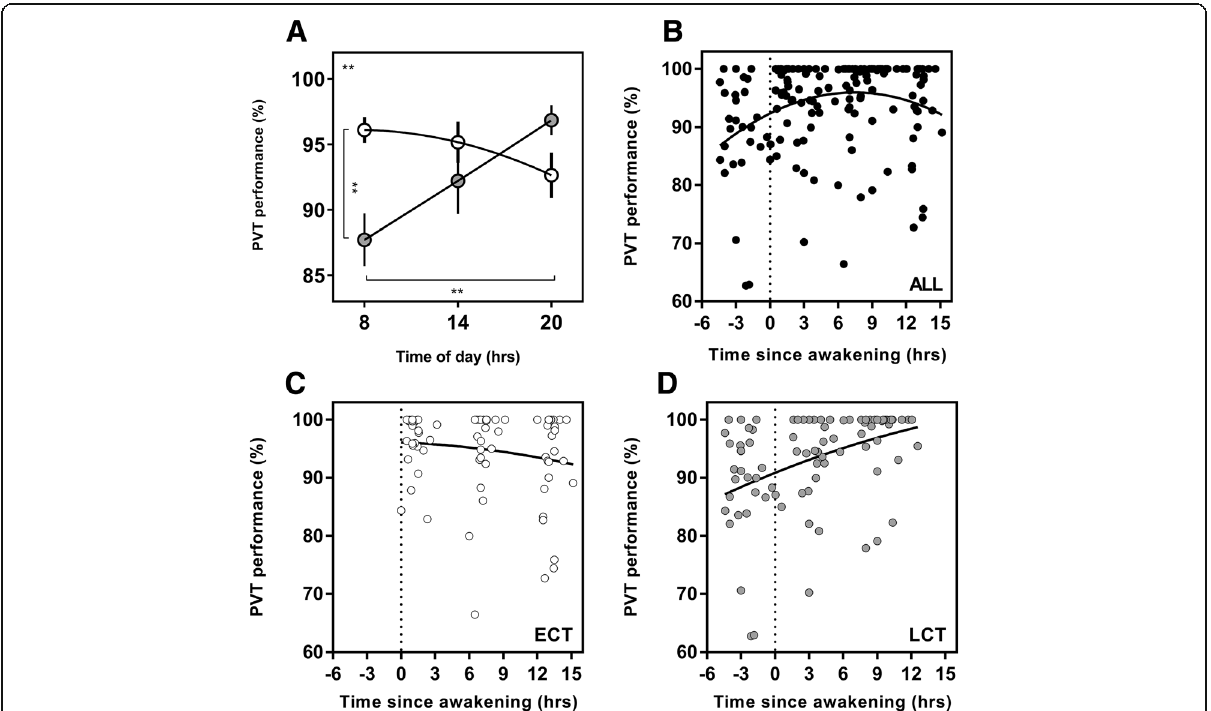
Fig. 2 Diurnal variation in psychomotor vigilance (PVT) and PVT as a function of time since awakening. Clock time variation ( a ) in PVT performance between ECTs (white circles) and LCTs (grey circles). PVT as a function of time since awakening for all subjects ( n =56; b ), ECTs ( n =25; c ), LCTs ( n =31; d ). Data are expressed as the percentage of individual personal best performance. Entrained wake-up time, i.e. biological time 0, is shown with the dotted line. Curves are second-order polynomial non-linear regressions. The significance is shown as *= p <0.05, ** = p <0.01, *** = p <0.001, **** p < 0.0001. The result shown in the upper left of ( a ) plots represents the interaction between the time of day and chronotype derived from the overall two-way ANOVA. Post hoc test results are shown with lines and asterisk between the time of day and chronotype